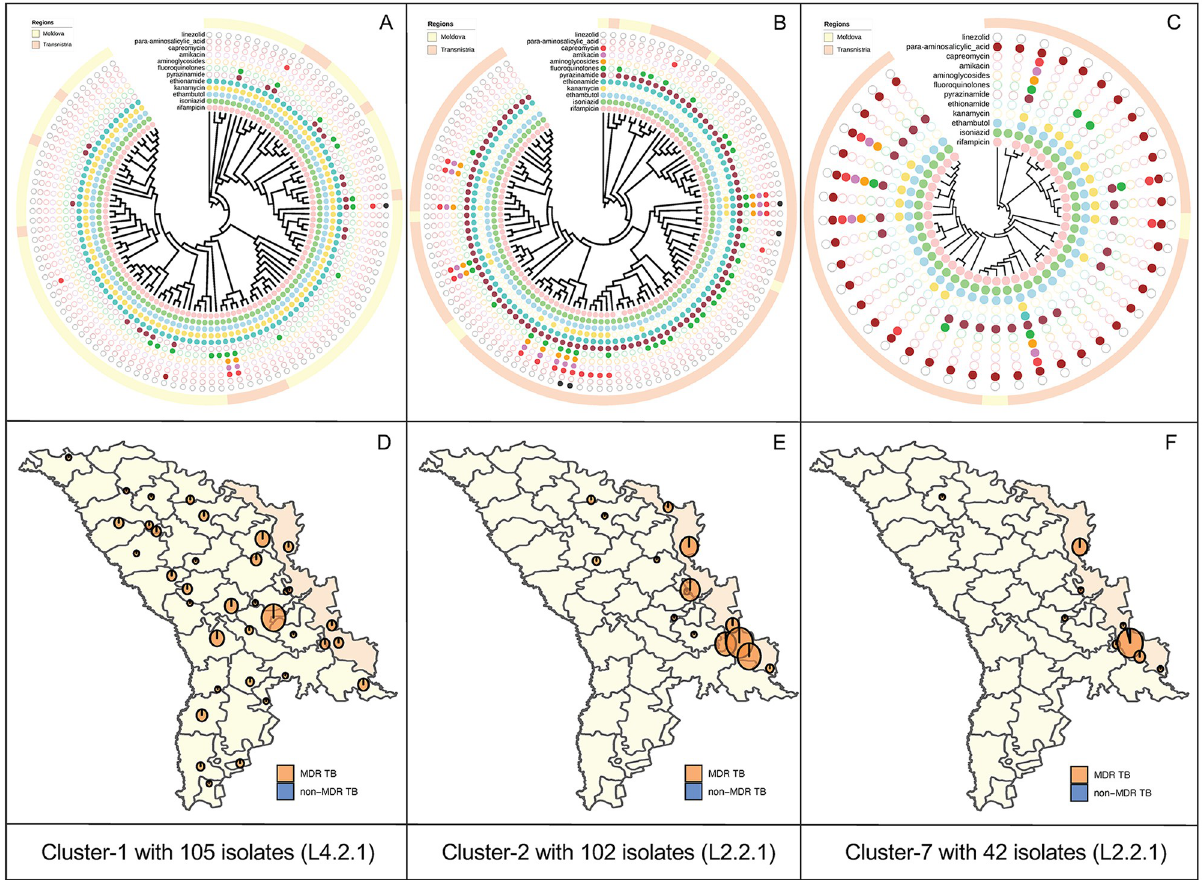
Fig 3. (A–C) Tree visualizations for 3 large putative transmission clusters ( N � 10 isolates), each showing the location of cases in either the Moldova or Transnistria regions along with resistance/susceptibility to 12 anti-TB drugs, as identified by in silico prediction. (D, E) Spatial distribution of 3 largest clusters (Cluster 1, 2, and 7) in the Ural/Lineage 4.2.1 and Beijing/lineage 2.2.1 clades. The map data were extracted from the GADM database (www. gadm.org/download_country.html). MDR-TB, multidrug-resistant tuberculosis; TB,